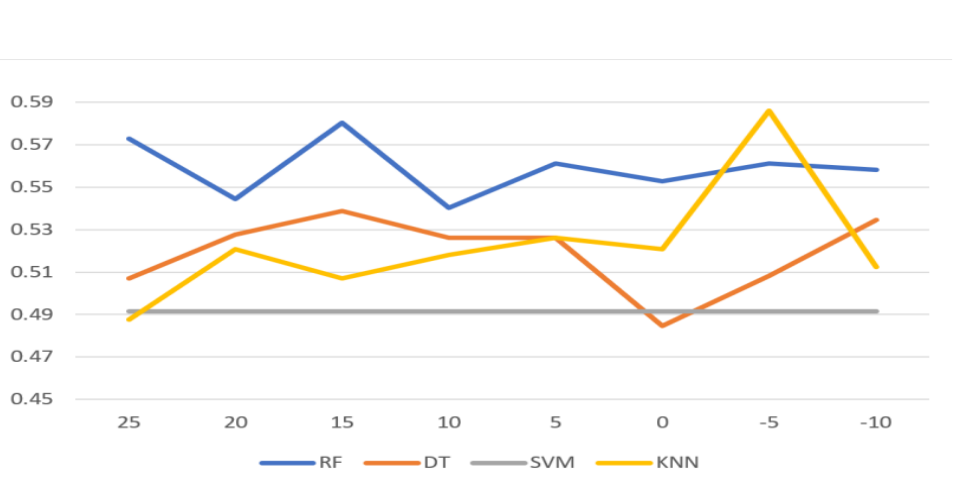
Figure 3. The Flow Diagram of Accuracy of Classification Methods applying the phase of samples Table 3. The Accuracy of each Classification Method in Its Signal Noise Ratio by Converting the Com-